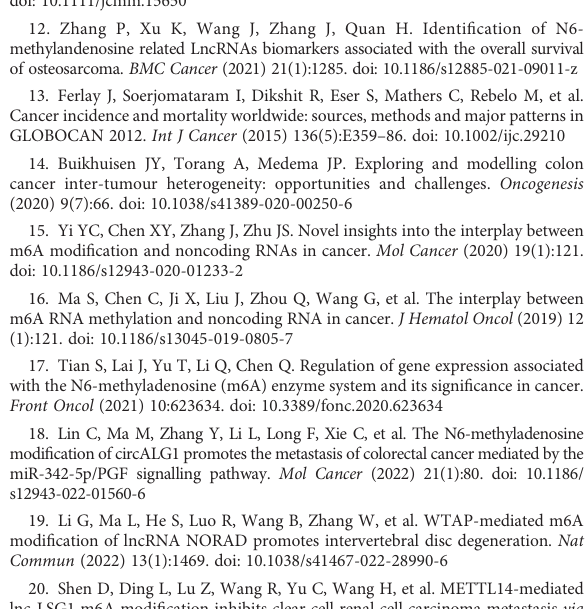
SUPPLEMENTARY FIGURE 1 (A – C) KM survival curves of DSS, PFI, and DFI between the high- and low- risk groups.